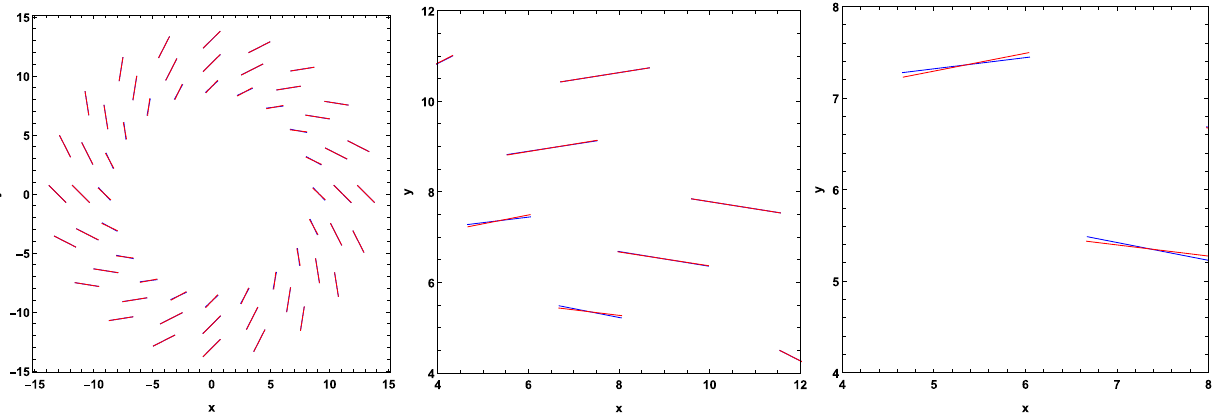
Fig. 10 Difference of the total observed polarization in the cases α = − 0 . 4 and α = 0 . 4 for θ o = 0 ◦ . The red line and the blue line correspond to α = − 0 . 4 and 0 . 4, respectively. The panel on the right is an enlargement of that in the left. Here, we set M = 1